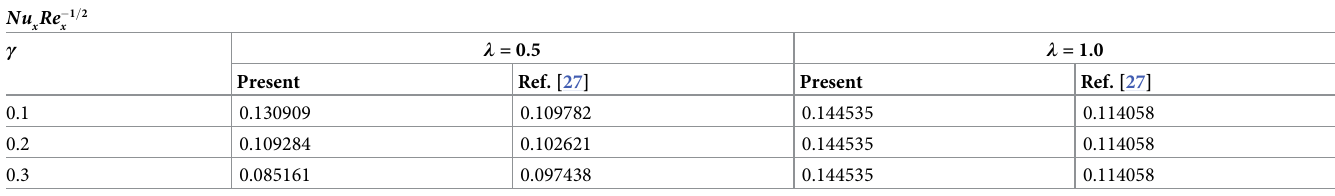
Table 2. Study of the relation of present findings with Ref. [27] without Rd